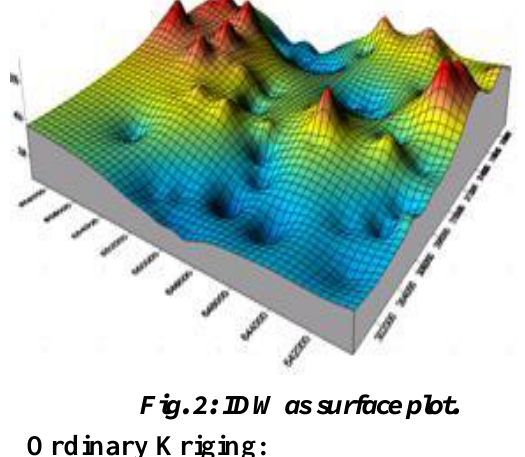
Fig. 2: IDW as surface